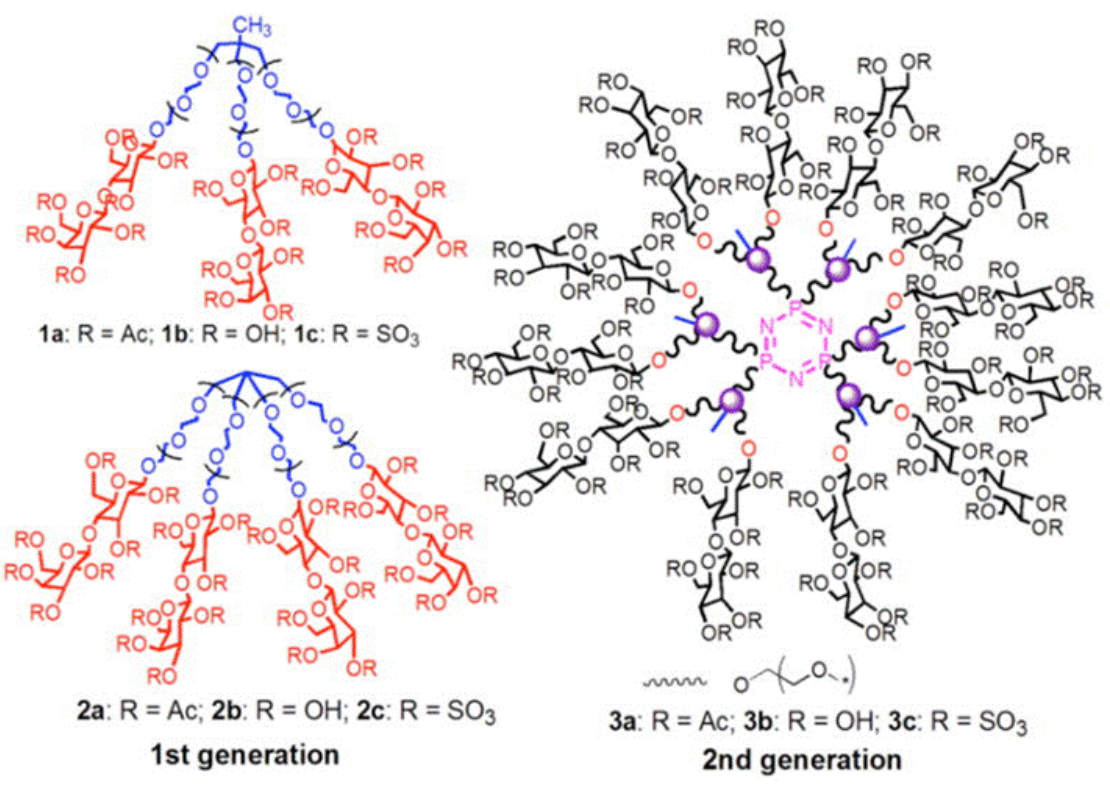
FIGURE 5. Structure of PEO glycosylated three-arm (1a, b, and c) and four-arm (2a, b, and c) ―stars‖ and N P core–based PEO glycodendrimers (3a, b, and c). (Reprinted with permission from Rele et al. J. Am. 3 3 Chem. Soc. 127 , 10132–10133. Copyright 2005 American Chemical